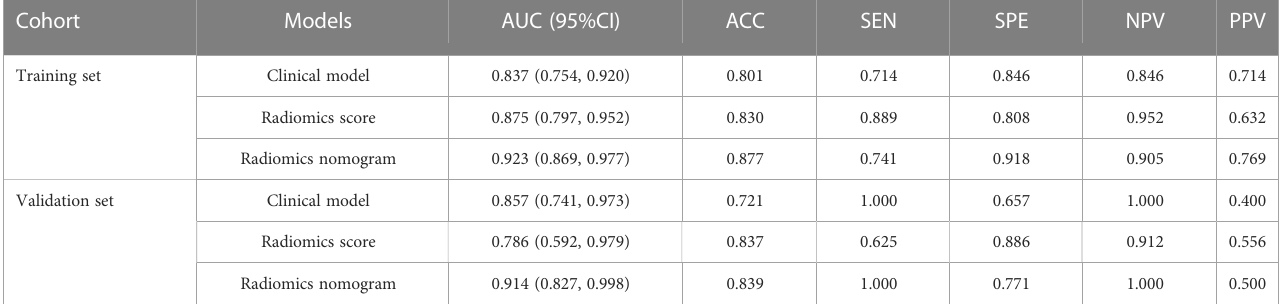
TABLE 3 Predictive performance of the clinical model, radiomics score, and radiomics nomogram for high-grade endometrial cancer. Cohort